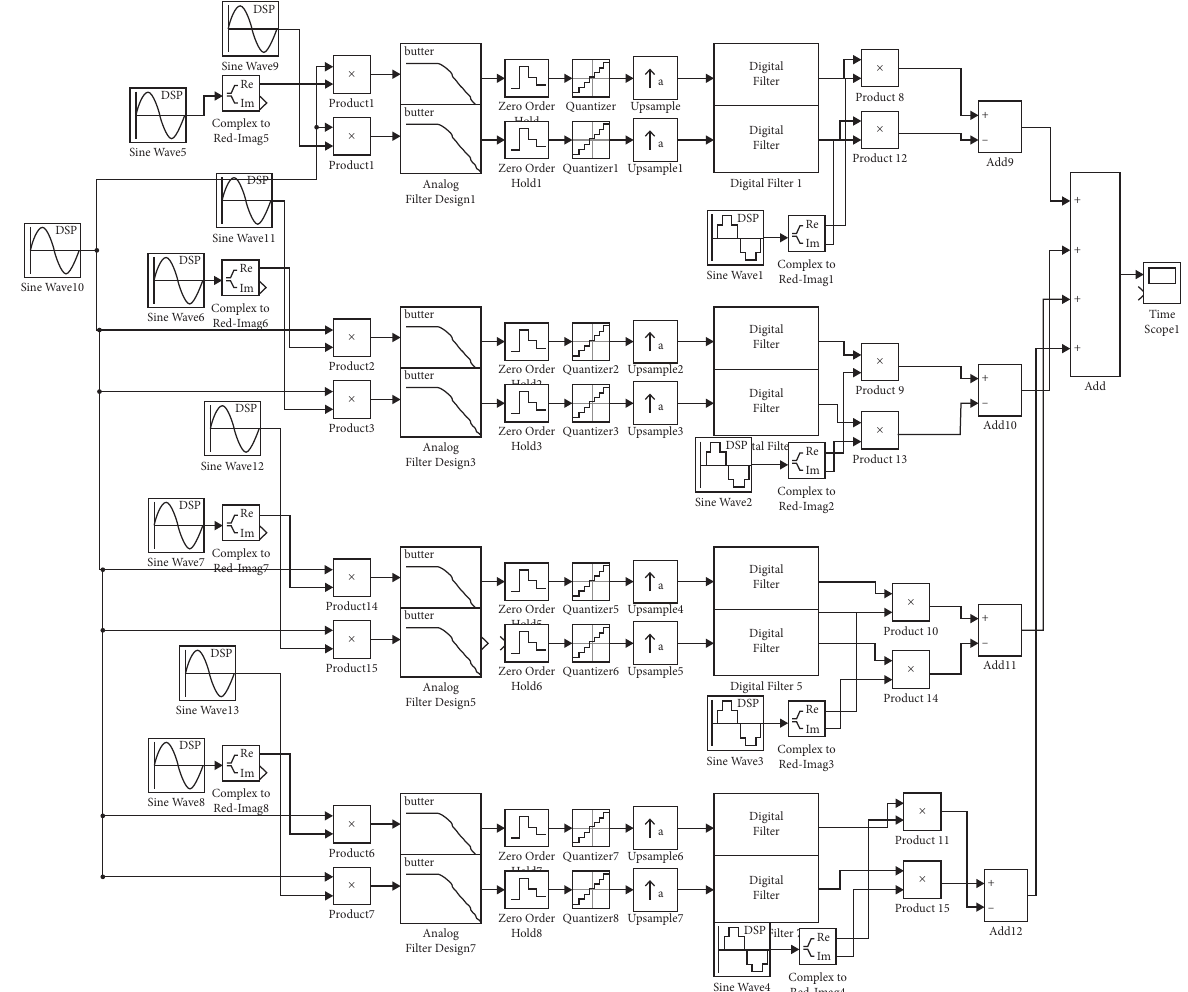
Figure 2: Simulink model of 4-channel high-speed system with IQ